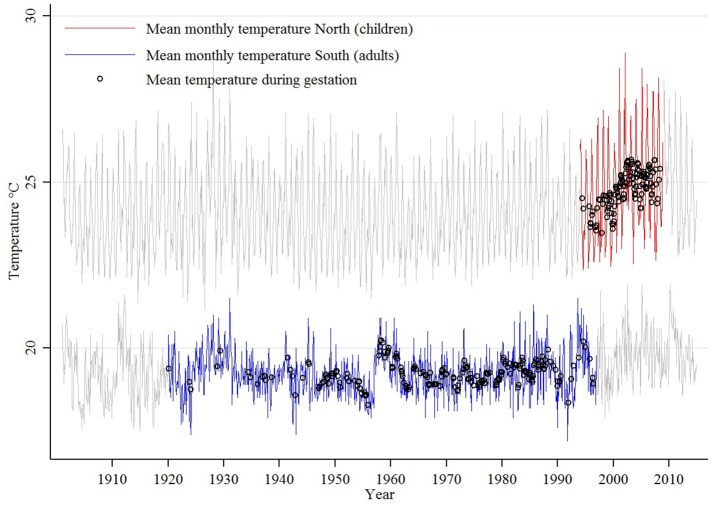
Temperature trends.